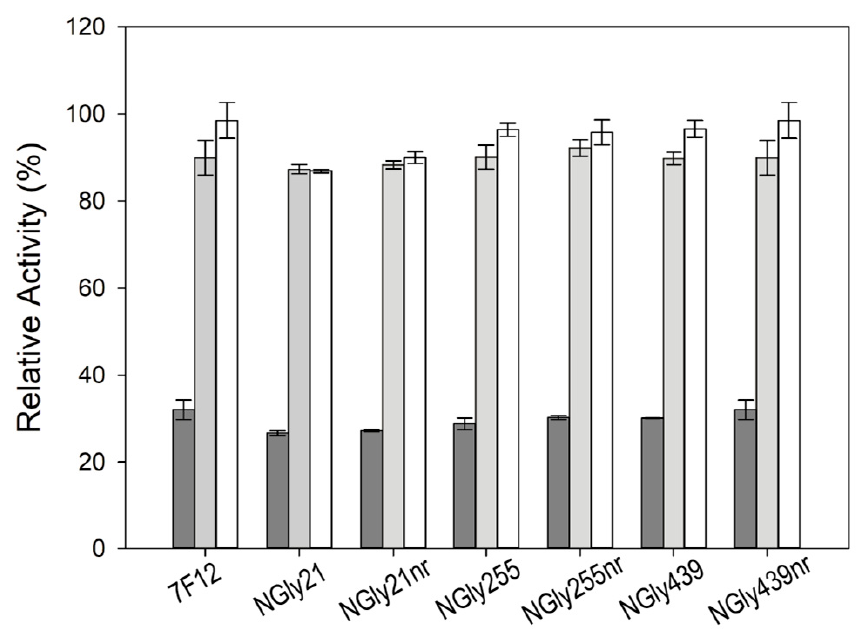
Figure 5. Concanavalin A affinity chromatography of the native glycosylated 7F12 laccase and its NGly21, NGly255 and NGly439 variants. The different N -glycosylation patterns are indicated by the percentages of laccase activity found in the non-retained fraction ( left ) and in the retained-glycosylated-fraction ( right ) in each variant. Protein profile was monitored by A280 nm (blue); the drop in conductivity (green) indicates the change to elution buffer to recover the glycosylated form retained in the column.